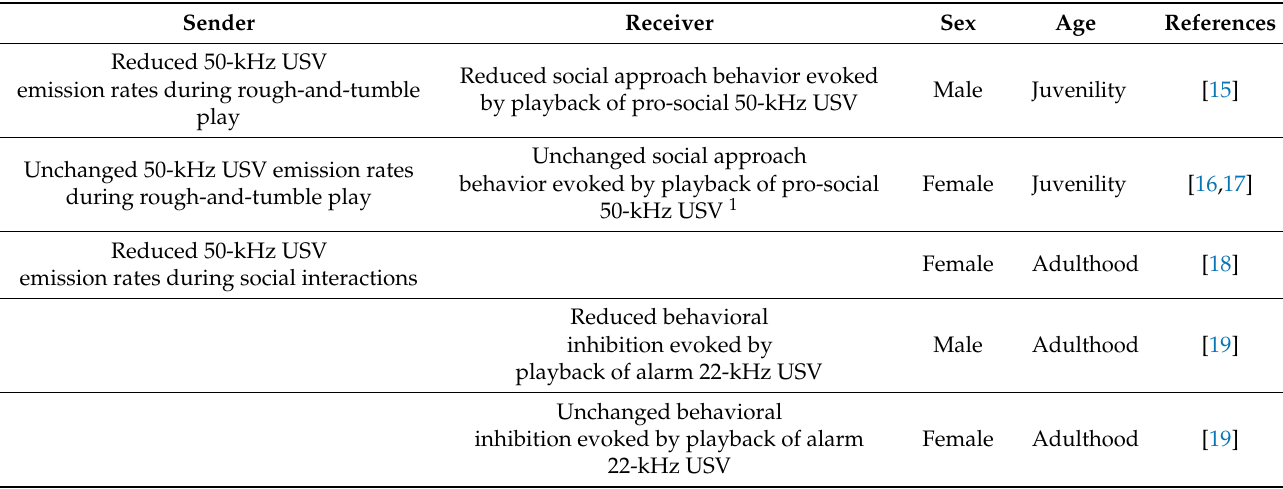
Table 1. Effects of Cacna1c haploinsufficiency on ultrasonic communication in